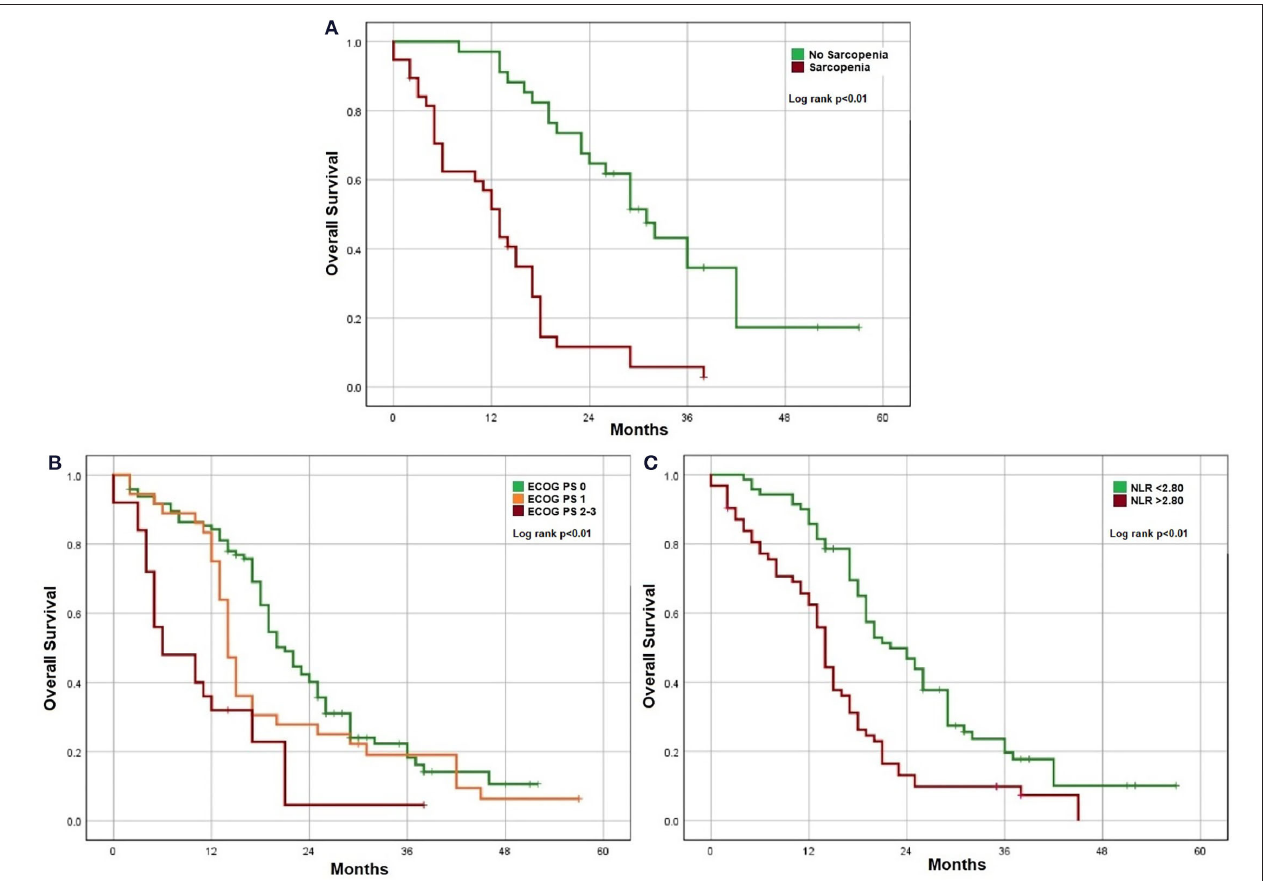
FIGURE 1 | Factors associated with OS. (A) Sarcopenia. (B) ECOG performance status. (C) Systemic inflammation.